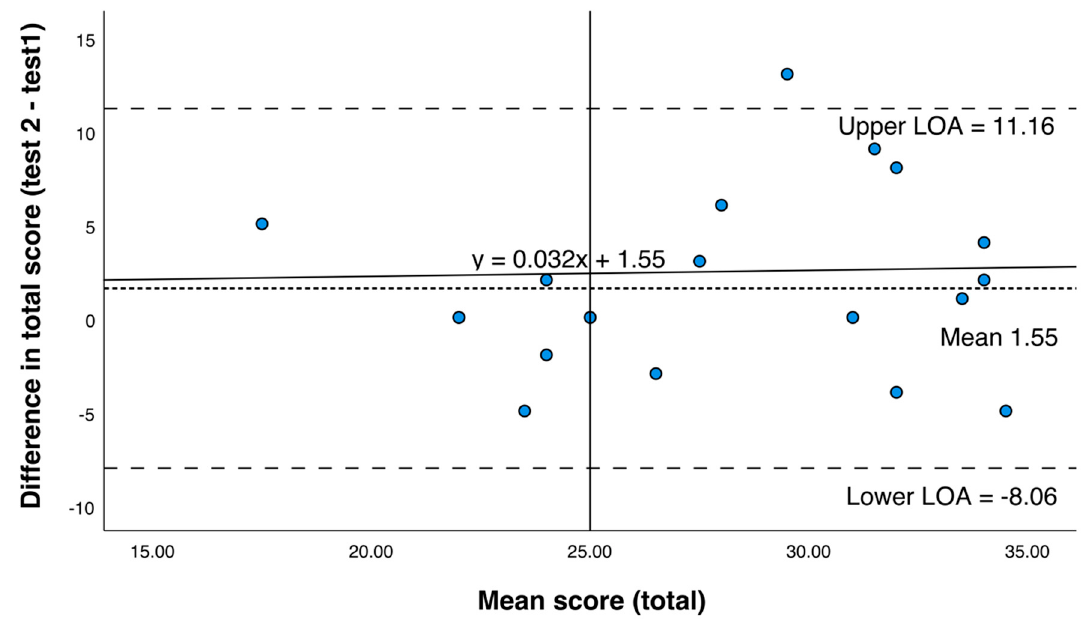
Figure 3. Bland Altman Plot assessing the reliability of Med-NKQ-20 during test re-test. The plot shows the mean difference ( …..….. ), 95% limits of agreement (LOA, - - - - - - - ), and fitted regression line ( _______ ), for overall test score (test 2 - test 1), β = 0.032, t = 0.136 p = 0.893, 95% CI ( − 0.469, 0.535), equation of line y = 0.032x +1.55.